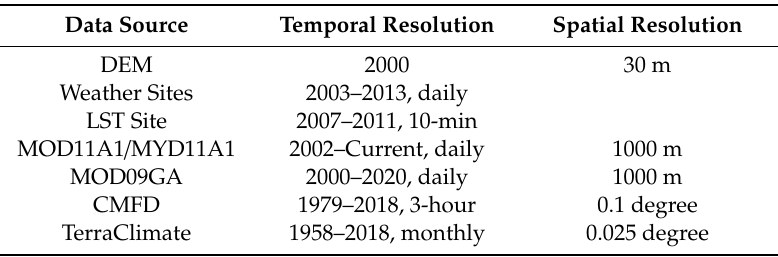
Table 1. Overview of datasets across the